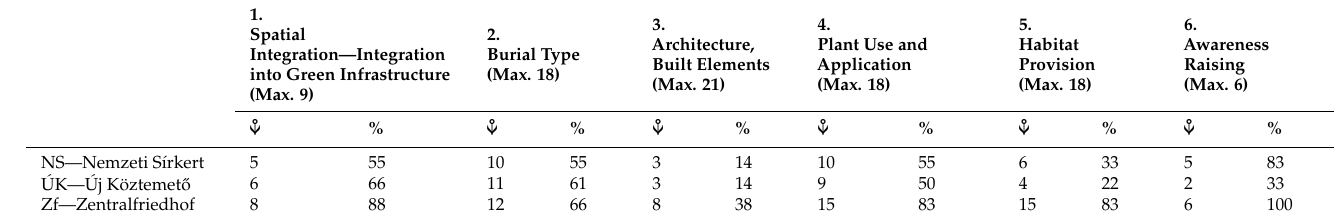
Table 3. Environmental (habitat) values of cemeteries—summary (authors’ table).